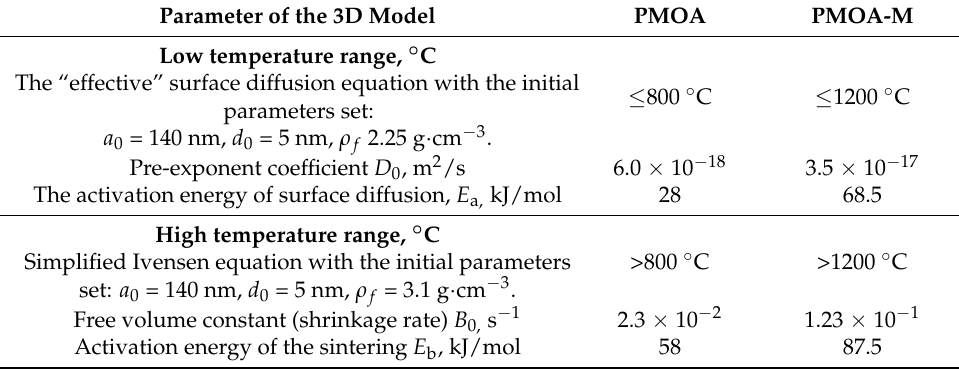
Table 4. 3D model parameters of PMOA and PMOA-M materials in temperature range 25–1700 ◦ C.